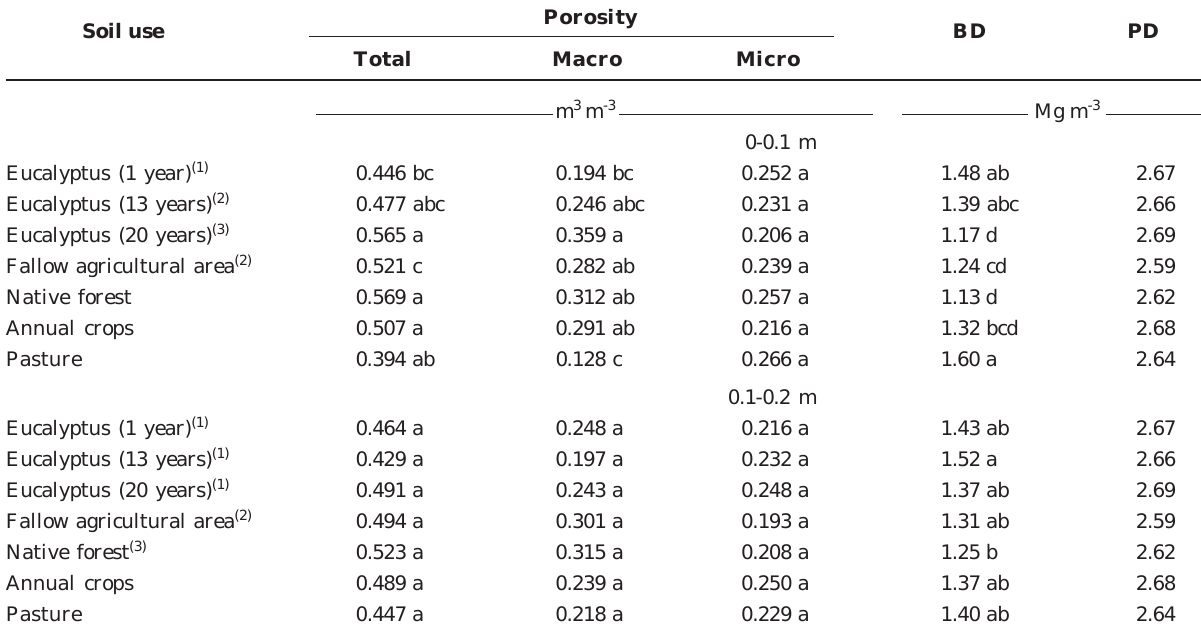
Table 2. Total pore volume, macroporosity, microporosity, bulk density (BD) and particle density (PD), at two depths in the soil under different